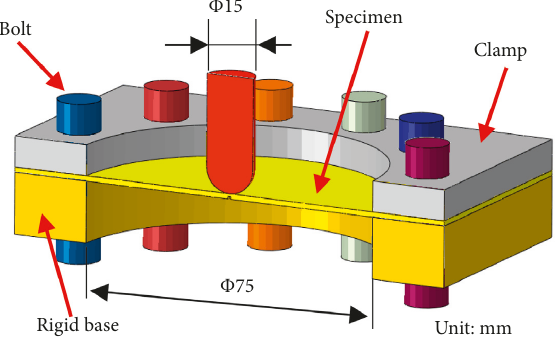
Figure 8: Schematic diagram of the clamped method.